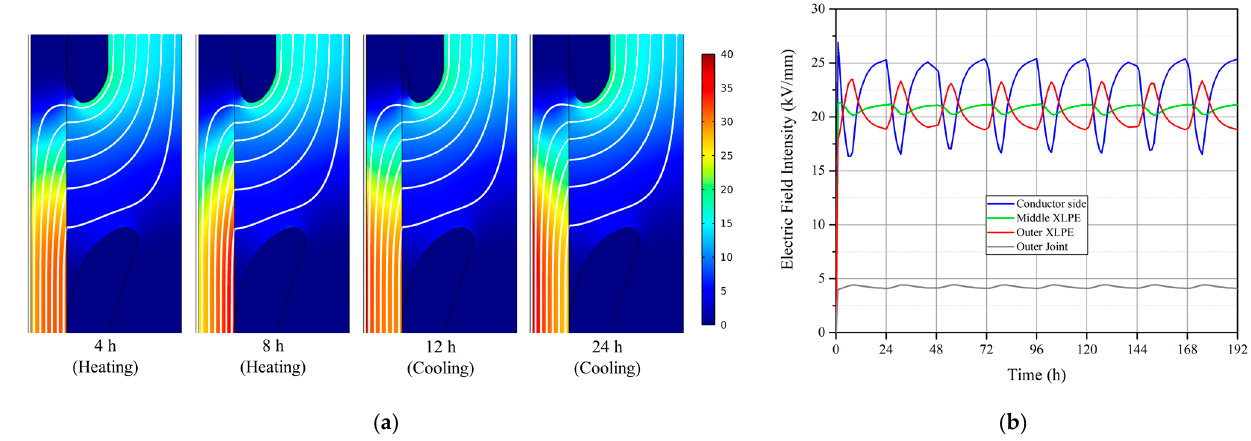
Figure 6. Electrical simulation results: ( a ) Time-varying electric field distribution and equipotential line; ( b ) Electric field profiles during the entire load cycles.